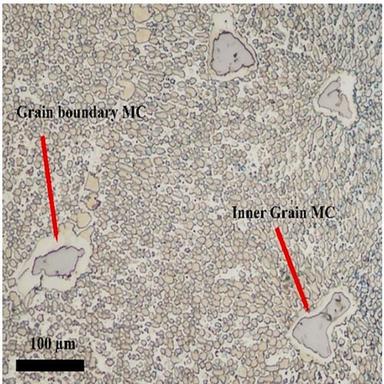
The comparison between grain boundary carbide and grain carbide (55,000 h exposed blade at LE 50% height).